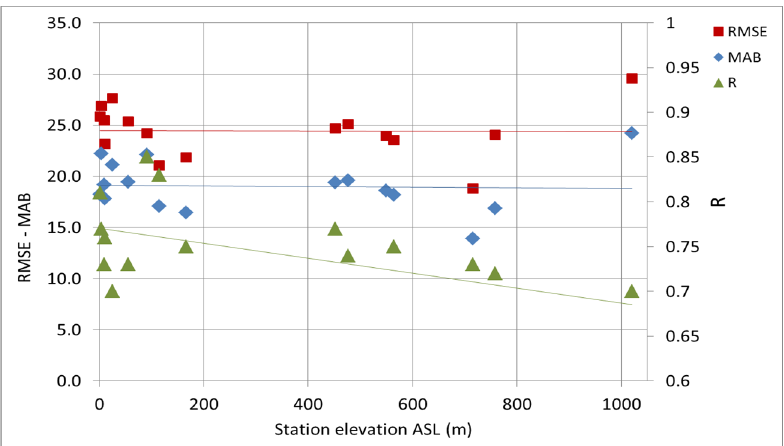
Figure 6. Distribution of model validation metrics (MAB, RMSE and PPC) per station elevation